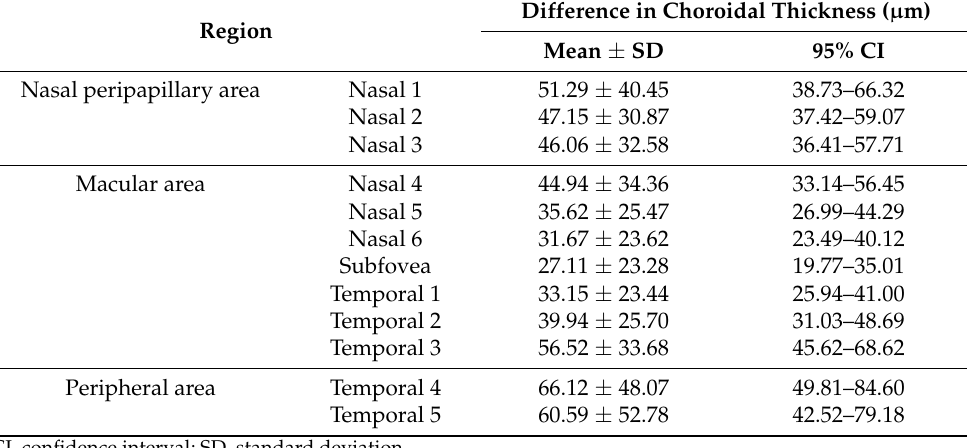
Table 3. Differences in absolute choroidal thickness between the right and left eyes at 12 measure- ment points.